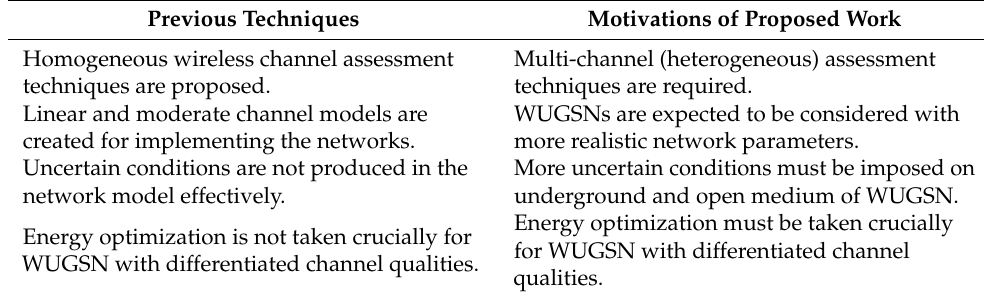
Table 1. Previous works and motivation of proposed